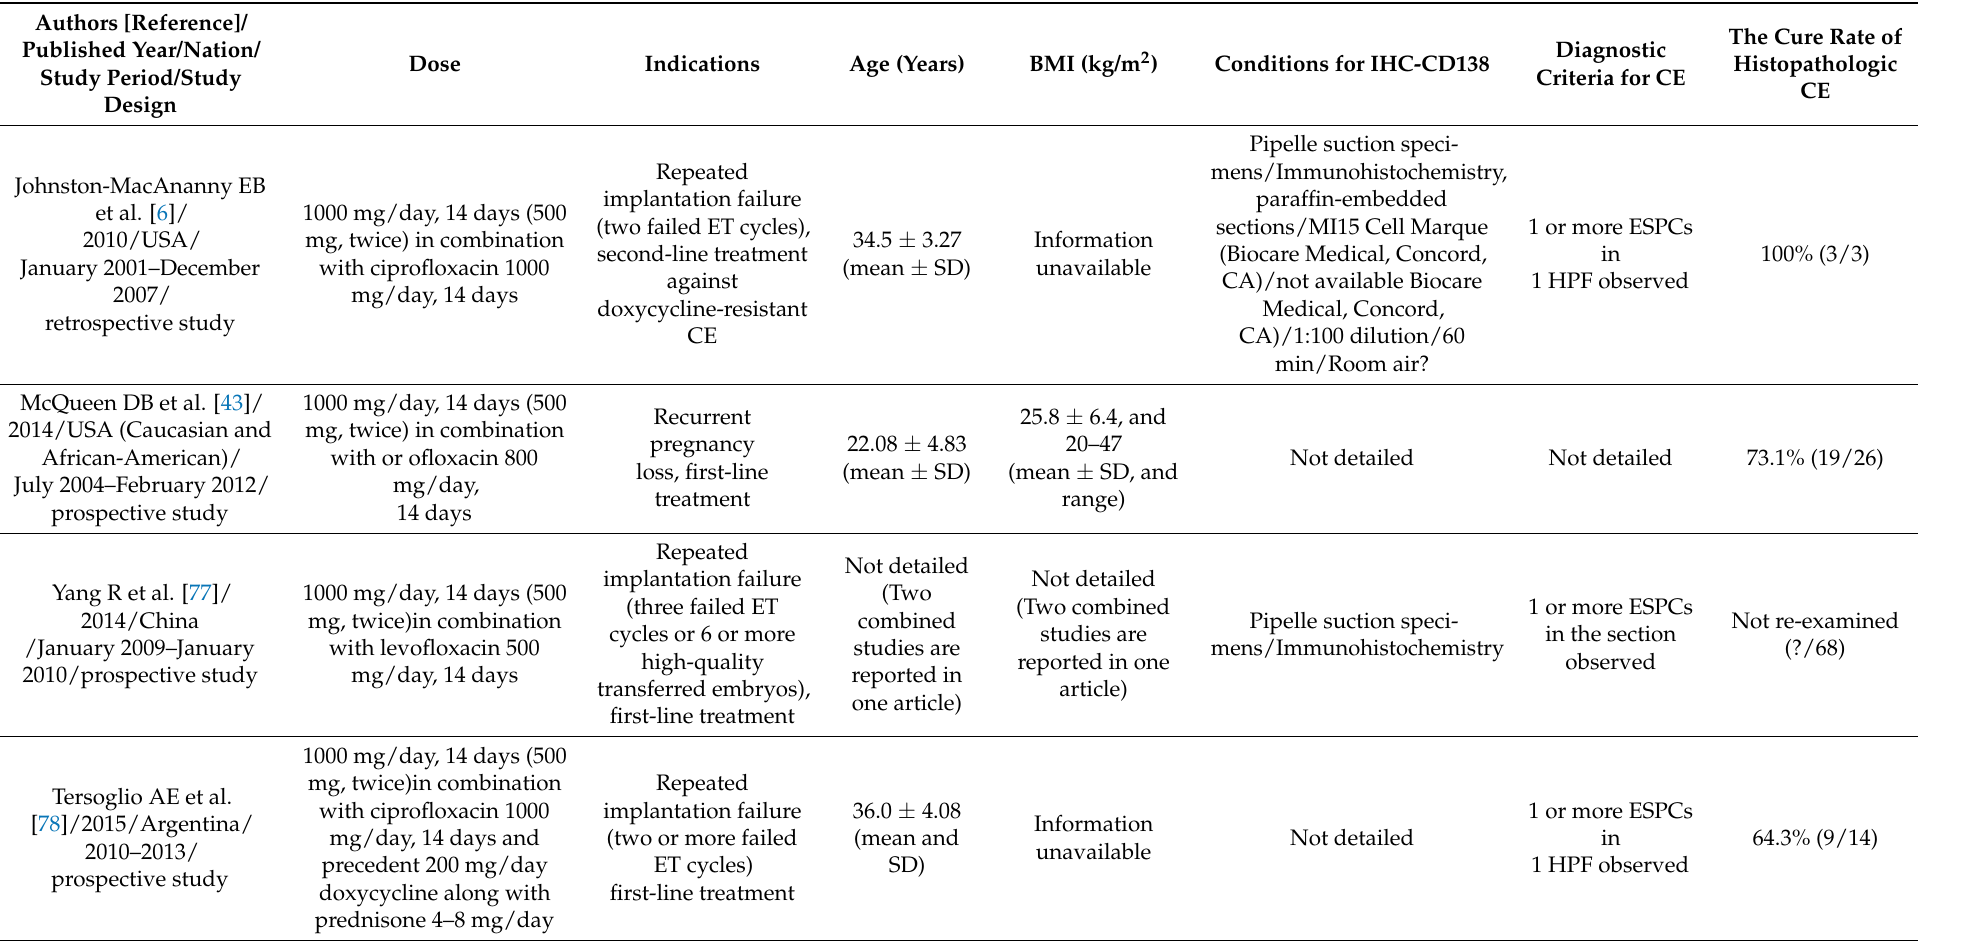
Table 2. Studies on the use of metronidazole against